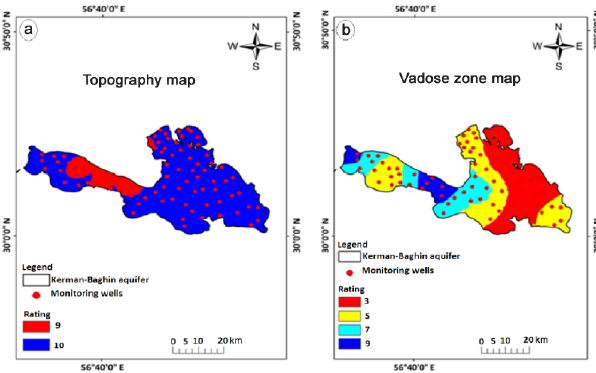
Figure 4. The Kerman–Baghin aquifer rated maps of (a) topogra- phy and (b) the vadose